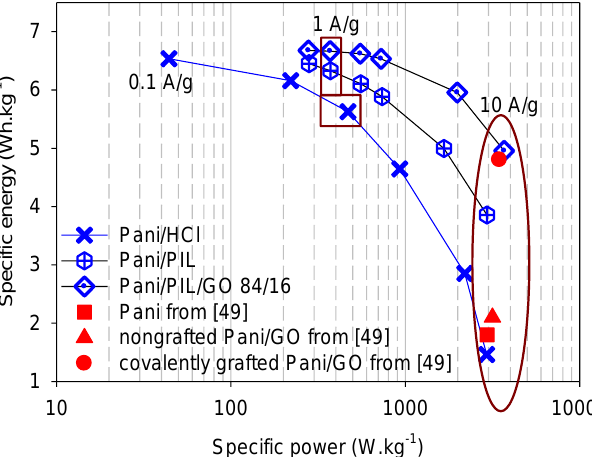
Figure 6. Ragone plot of the investigated materials vs. the materials studied in [49] in H 2 SO 4 1 mol · L − 1 . To show the importance of the addition of the PIL to the polymerization medium, the performance of our materials were compared with those of covalently grafted